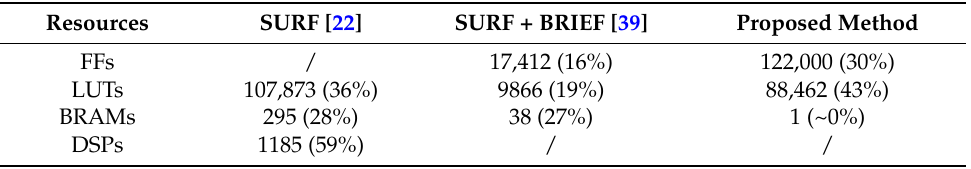
Table 4. The resource utilization by entity (XC7325T